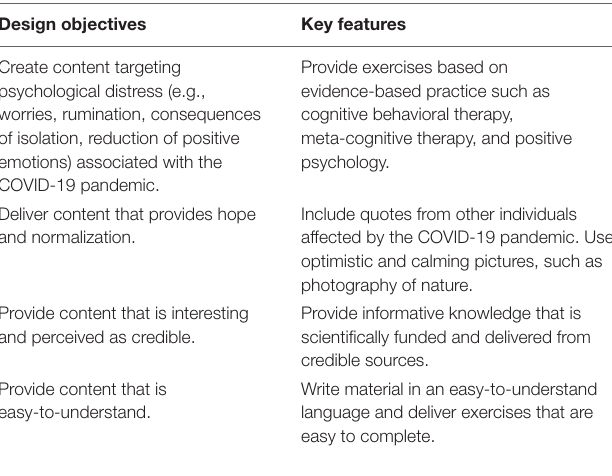
TABLE 1 | Guiding